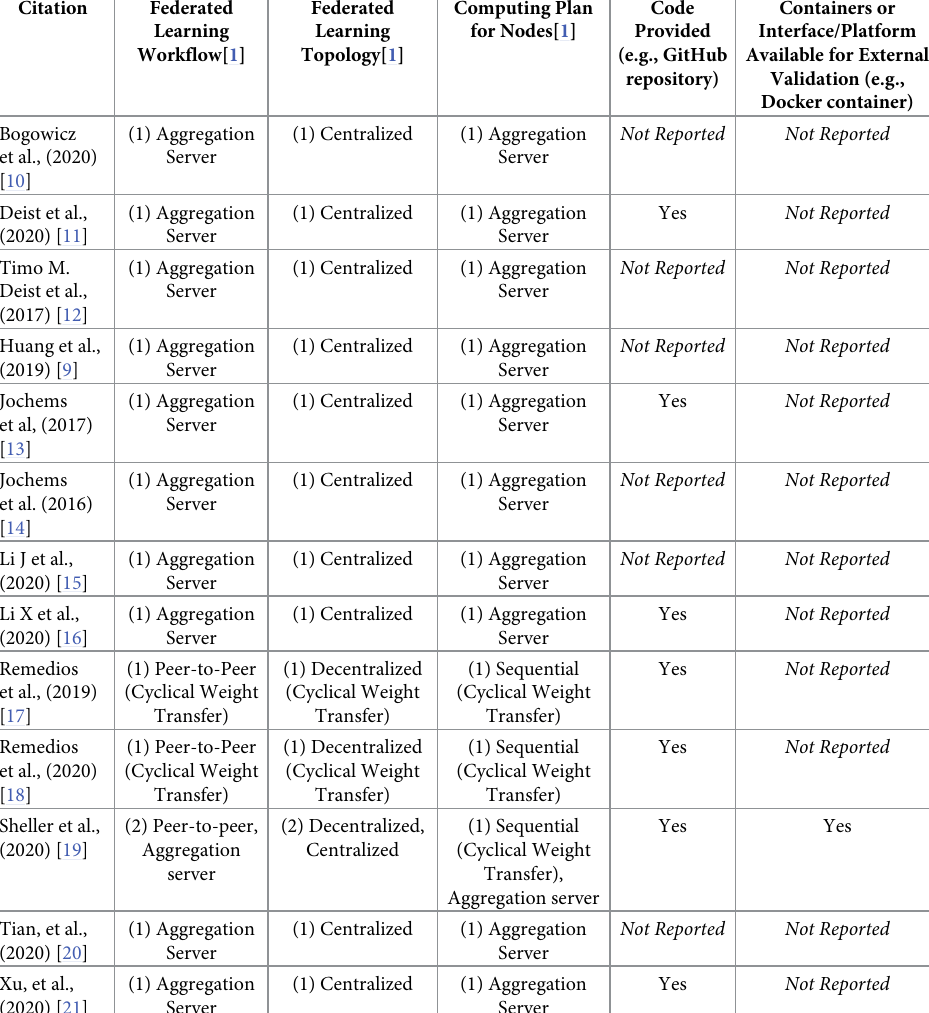
Table 4. Federated learning approach, topologies, and reproducibility of included studies. Workflow, topologies and computing plan classification adapted from Rieke et al.